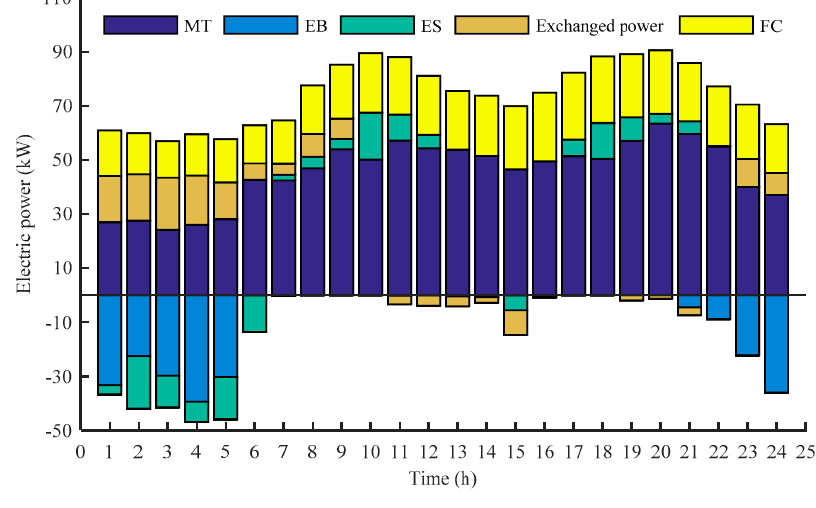
Figure 6. Results of electric power.